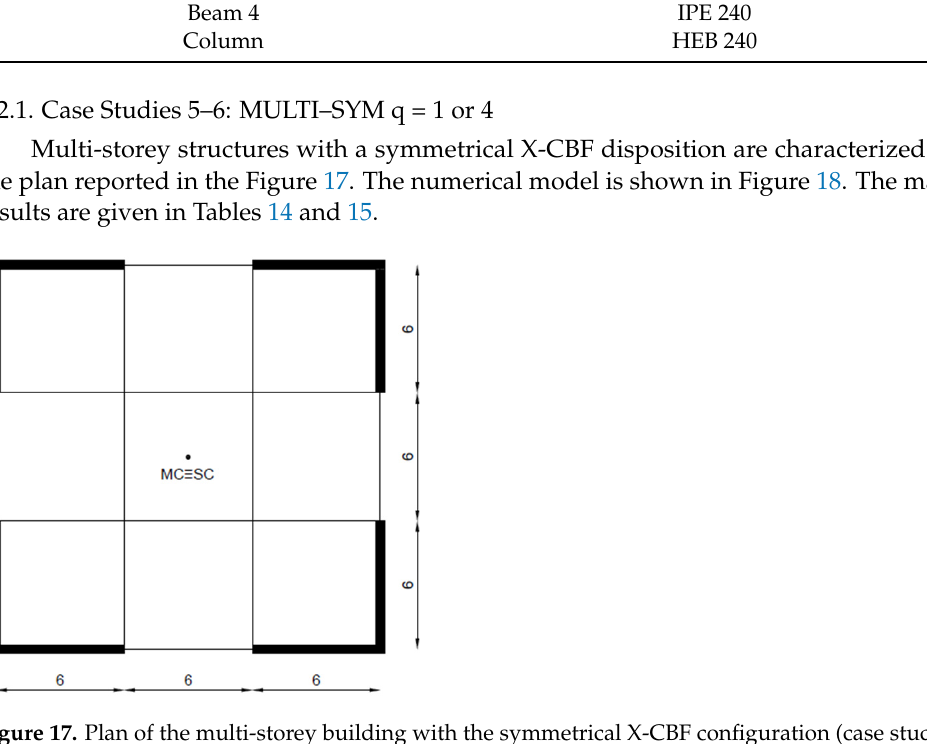
Figure 18. Multi-storey building model with SAP2000 for case studies 5 and 6. Table 11. Ratios between the shears from the linear dynamic analysis with corrected stiffness, and linear static analysis for one-floor building case studies. Case Studies